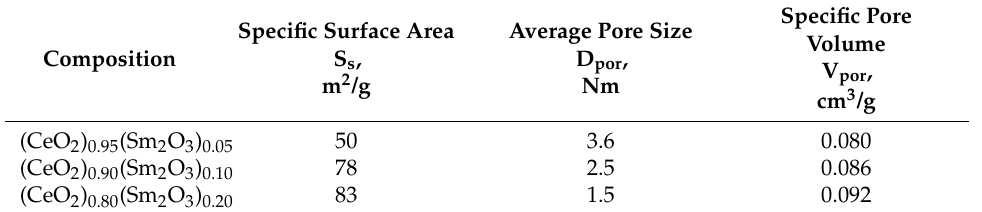
Table 1. Microstructure characteristics of the powders synthesized by co-precipitation of hydroxides, determined by low-temperature nitrogen